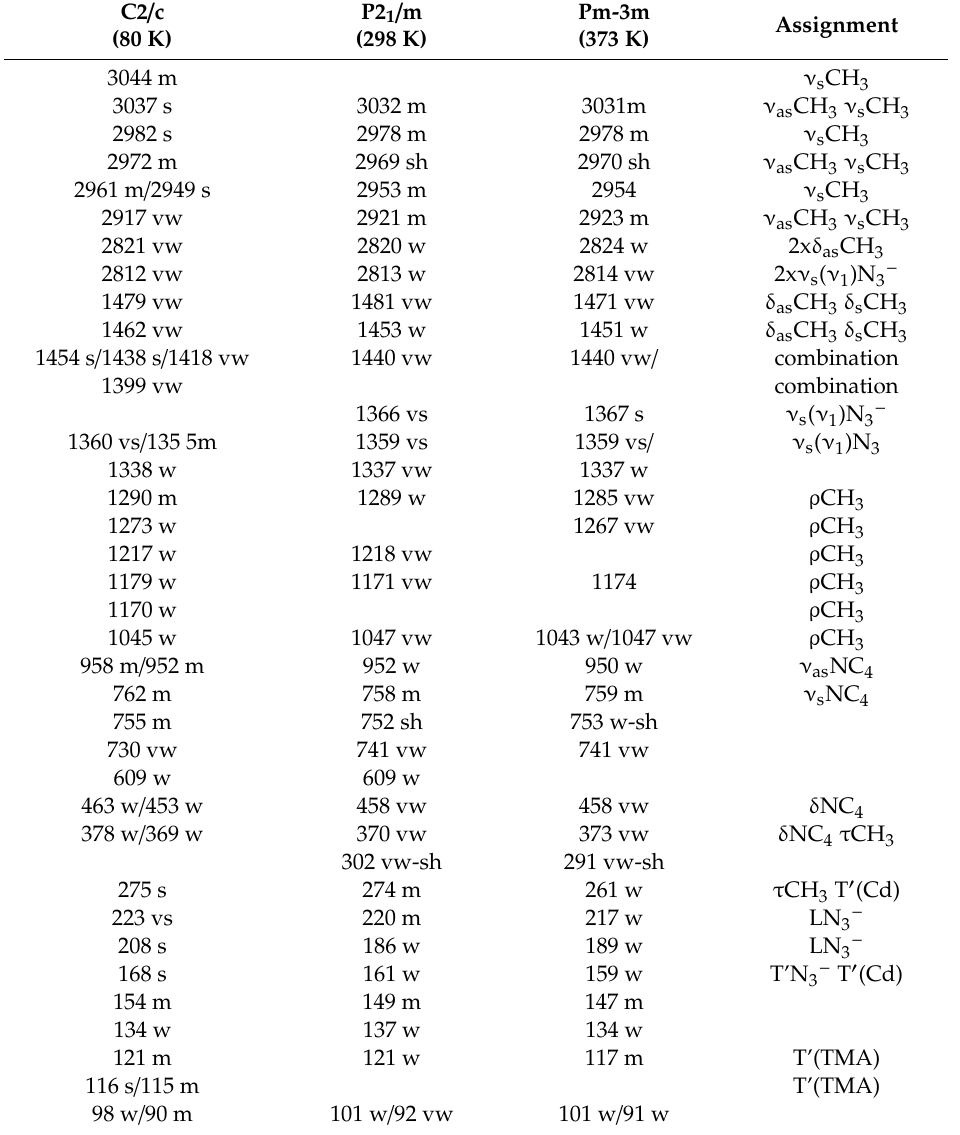
Table 2. Observed Raman modes (in cm − 1 ) of TMACdN 3 and their respective